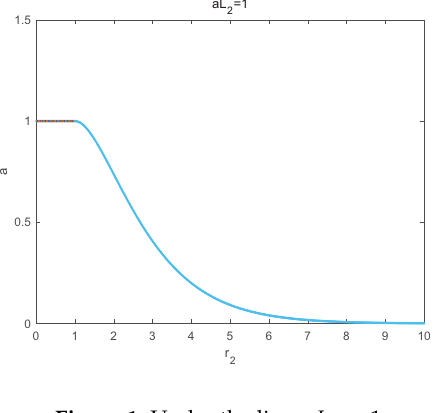
Figure 1. Under the line, aL 2 <